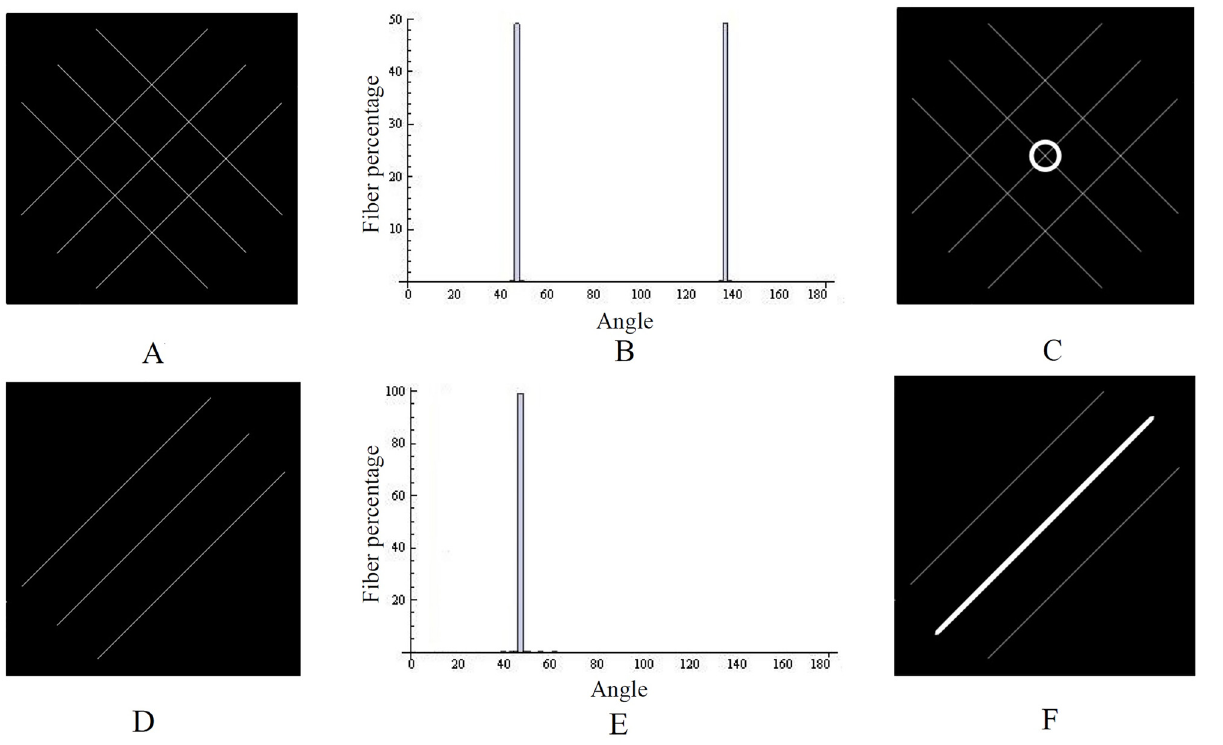
Fig 3. Artificial fibers with isotropic (A) and anisotropic (D) alignment, their corresponding histograms (B, E), and dispersity as ellipses (C, F). Isotropic fibers are shown as a circle and anisotropic fibers as a line.